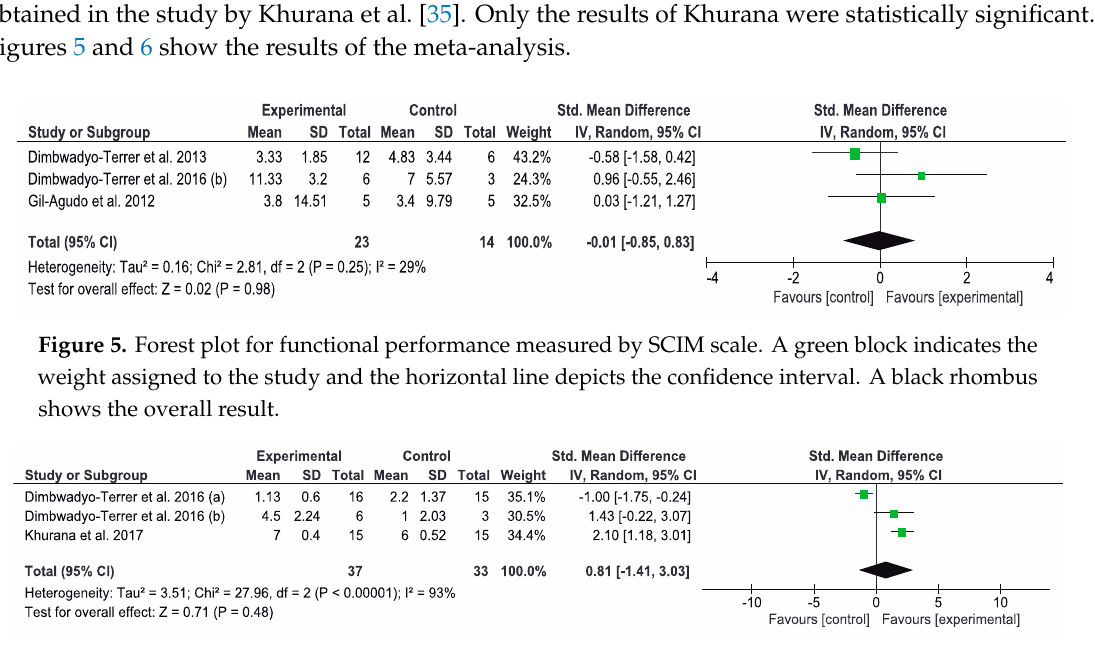
Figure 6. Forest plot for functional performance measured by SCIM self-care subtest. A green block indicates the weight assigned to the study and the horizontal line depicts the confidence interval. A black rhombus shows the overall result.